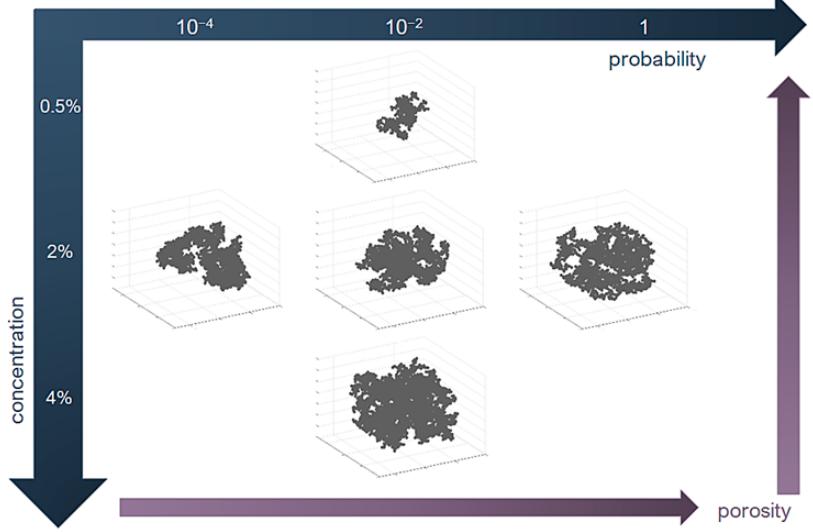
Figure 17. Overall scheme presenting relations between particle concentration, probability of effective collisions and structure properties: morphology, fractal dimension and porosity.